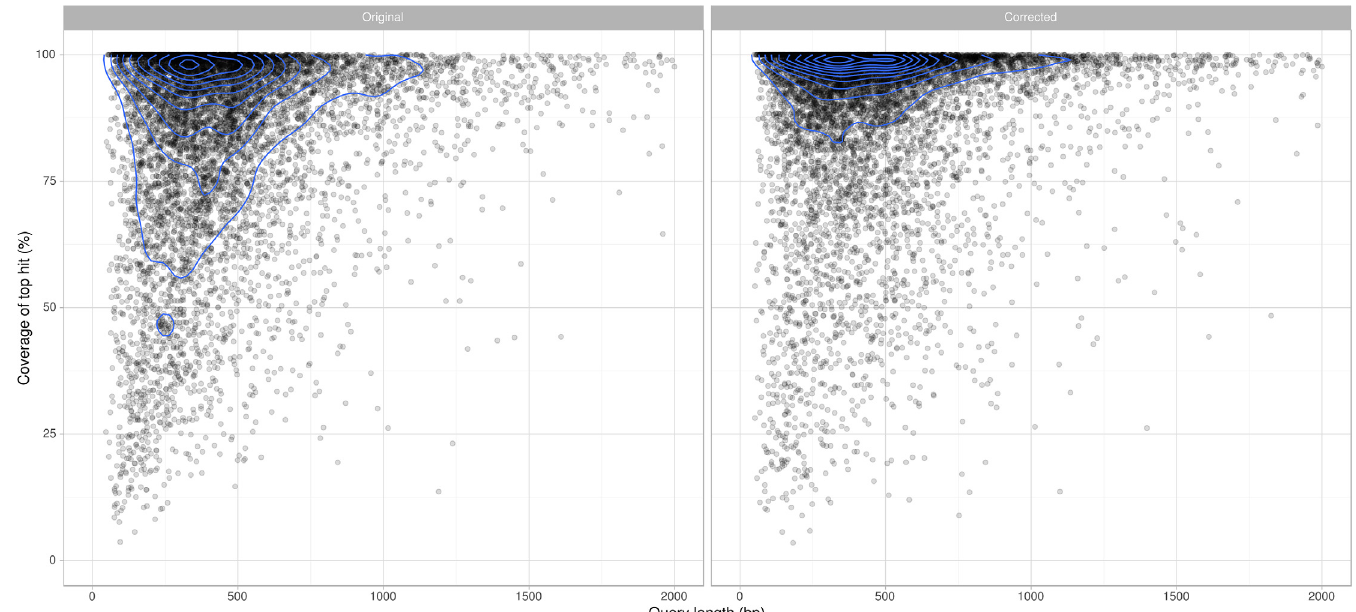
Fig 2. Coverage of the top BLASTP hit for re-annotated P . nodorum SN15 predicted proteins. The manually curated set (left) agrees more closely with sequences in the NCBI Protein NR database than the original set of annotations (right). Contour lines (blue) indicate ‘ kernel density ’ , depicting the relative number of proteins within a localised region of the